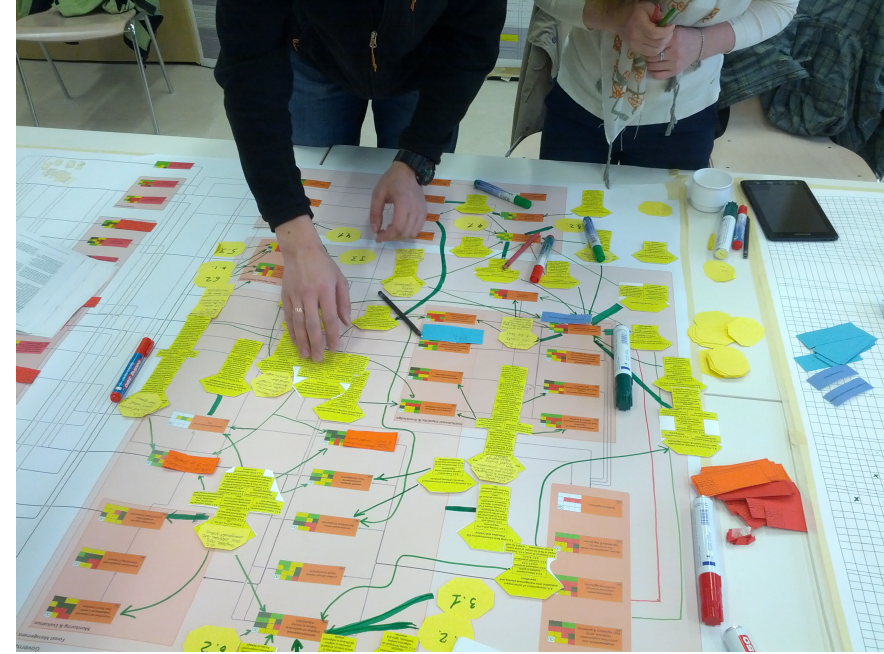
Figure 2. Experts identify the leverage points and influence (green and red arrows) of the Russian National FSC standard (yellow hexagons) and map it against contributing factors (orange boxes) in the conceptual model that illustrates the causally interlinked elements responsible for the situation in